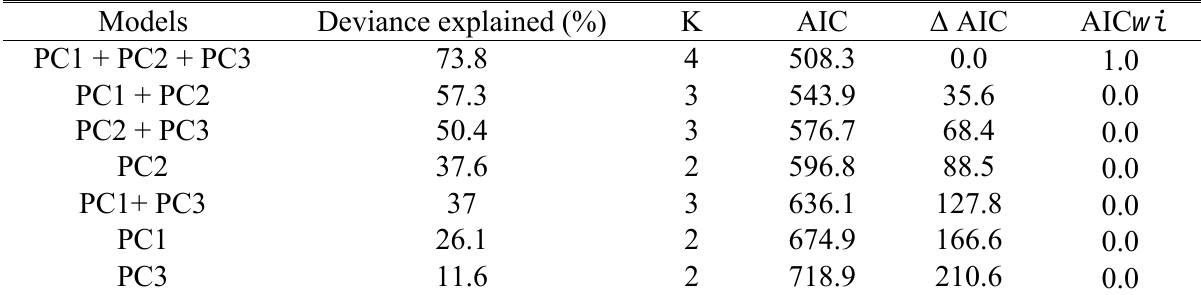
Table A1.3. Results of GAMs incorporating three principal components (PC) to predict: a) abundance, and b) presence of Northern Mealy Amazons during the breeding season (March 2014) in a modified landscape of tropical moist forest, Los Chimalapas, Mexico. Models are ordered by the lowest Akaike’s Information Criterion (AIC), with delta Akaike differences (ΔAIC), and Akaike weights (AIC wi ) between models. K = total number of parameters. a) Number of Northern Mealy Amazons at point